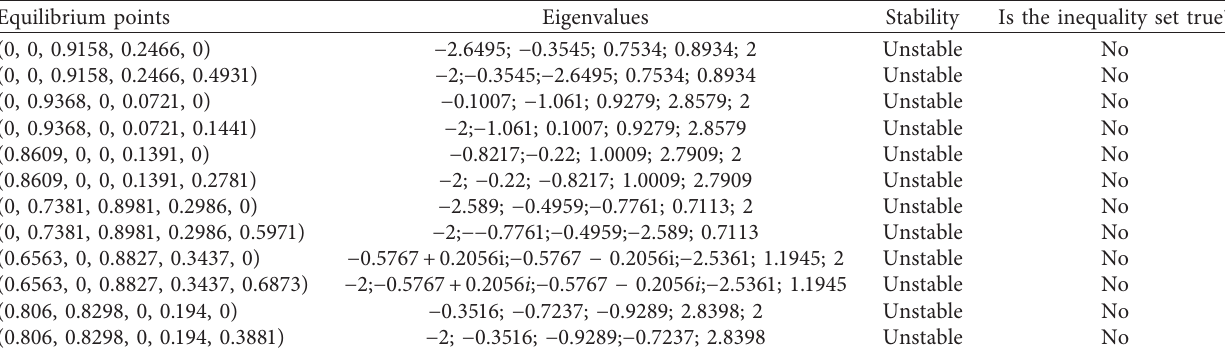
Table 1: The equilibrium points, the corresponding eigenvalue, the stability, and the conditional inequality systems true or no. Equilibrium points Eigenvalues Stability Is the inequality set